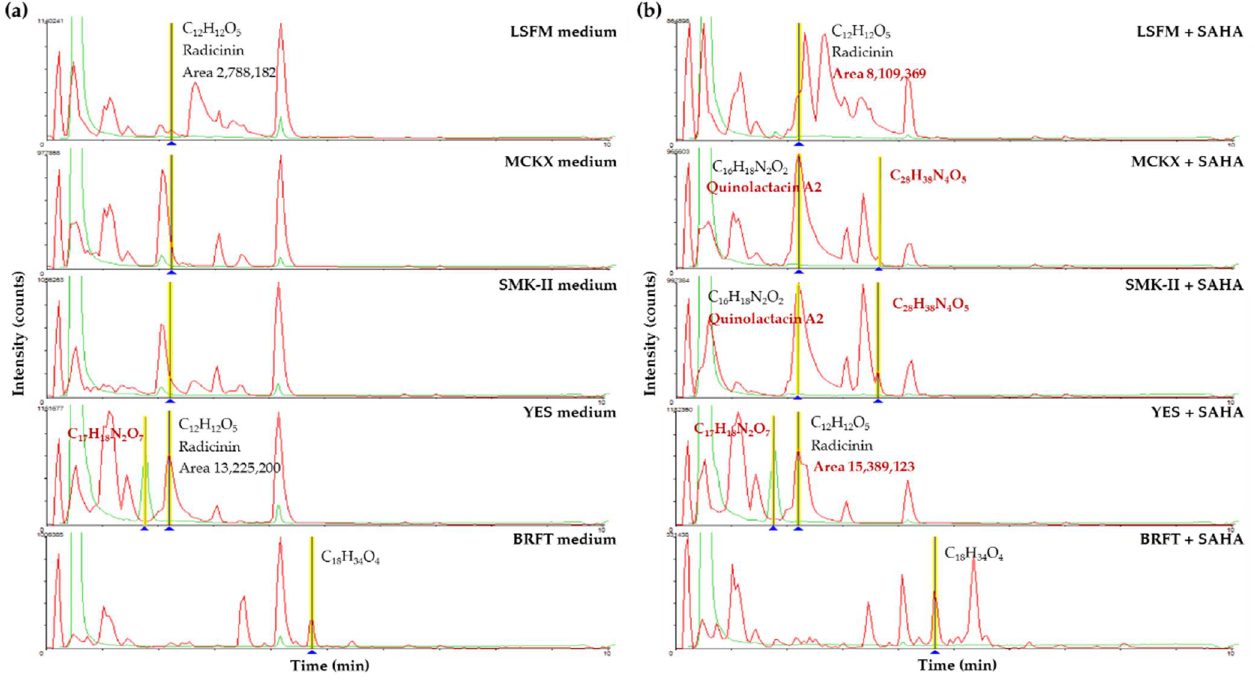
Figure 12. Comparative analysis of HR-MS profiles produced by fermentation of the strain Microxyphium sp. CF-164412 in five different media ( a ) without SAHA addition and ( b ) supplemented with SAHA. HPLC/UV at 210 nm profiles in green and HPLC/HR-MS profiles in red.